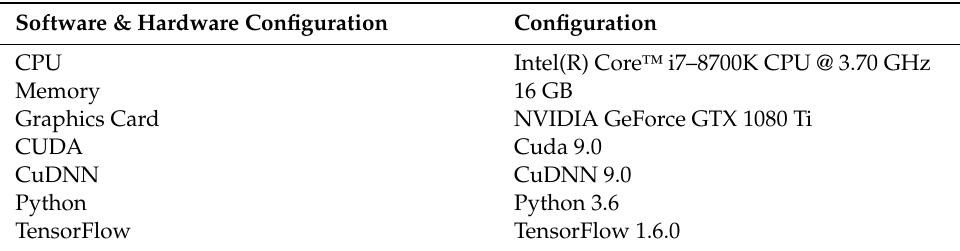
Table 1. Software and hardware